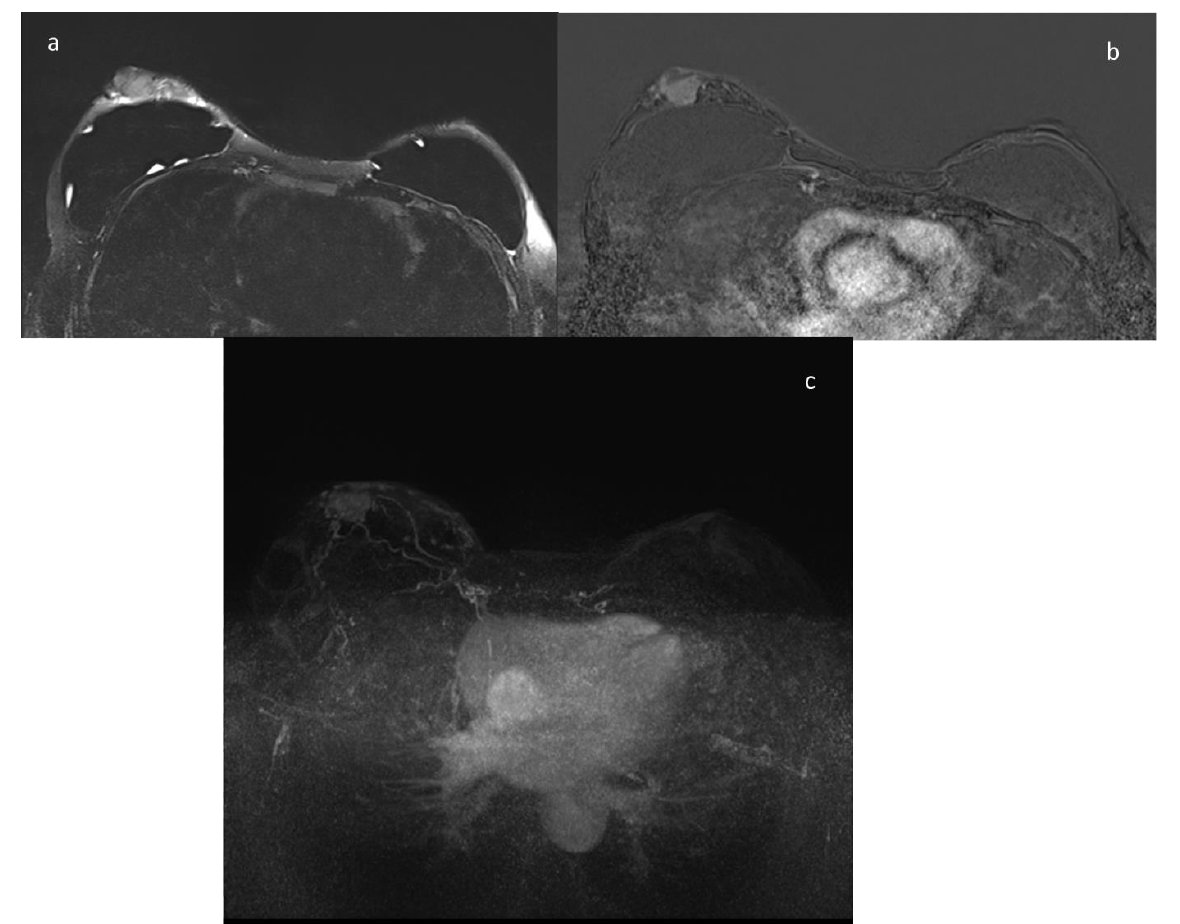
Figure 2. A 43-year-old patient with BRCA2 gene mutation; the patient underwent prophylactic mastectomy. At the annual ce-MRI screening a mass with irregular margins was identified in the retroareolar area of the right breast, corresponding at the US second look to a suspicious hypoechoic nodule that undergoes core needle biopsy with the diagnosis of invasive lobular carcinoma. ( a ) T2-weighted imagine; ( b ) contrast-enhanced image; ( c ) MIP image.